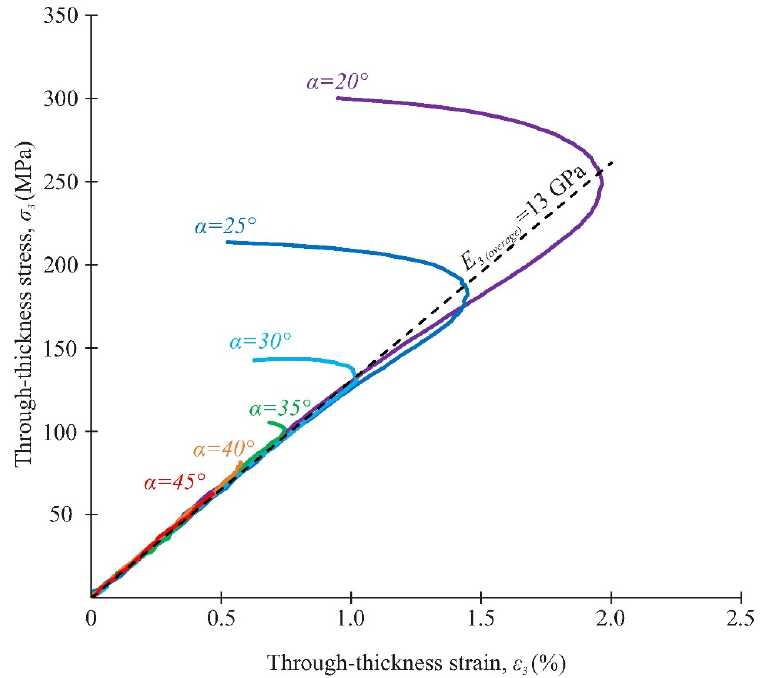
Figure 16. Through-thickness stress–strain curves under combined compression/shear loading.